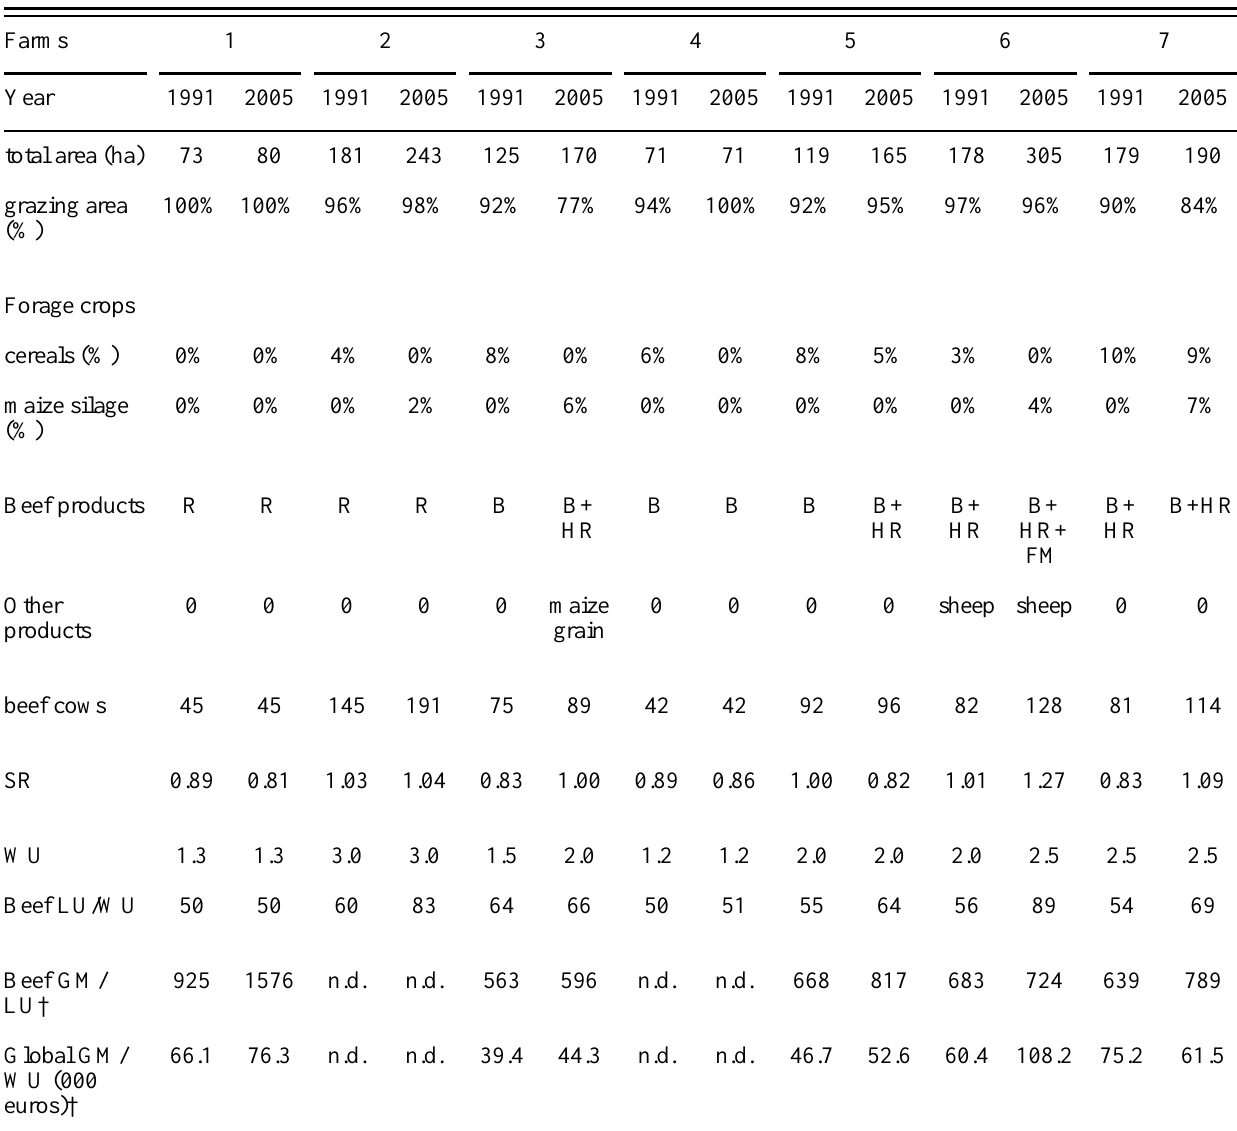
Table 1. Structural characteristics of the seven farms studied and changes between 1991 and 2005. Farms